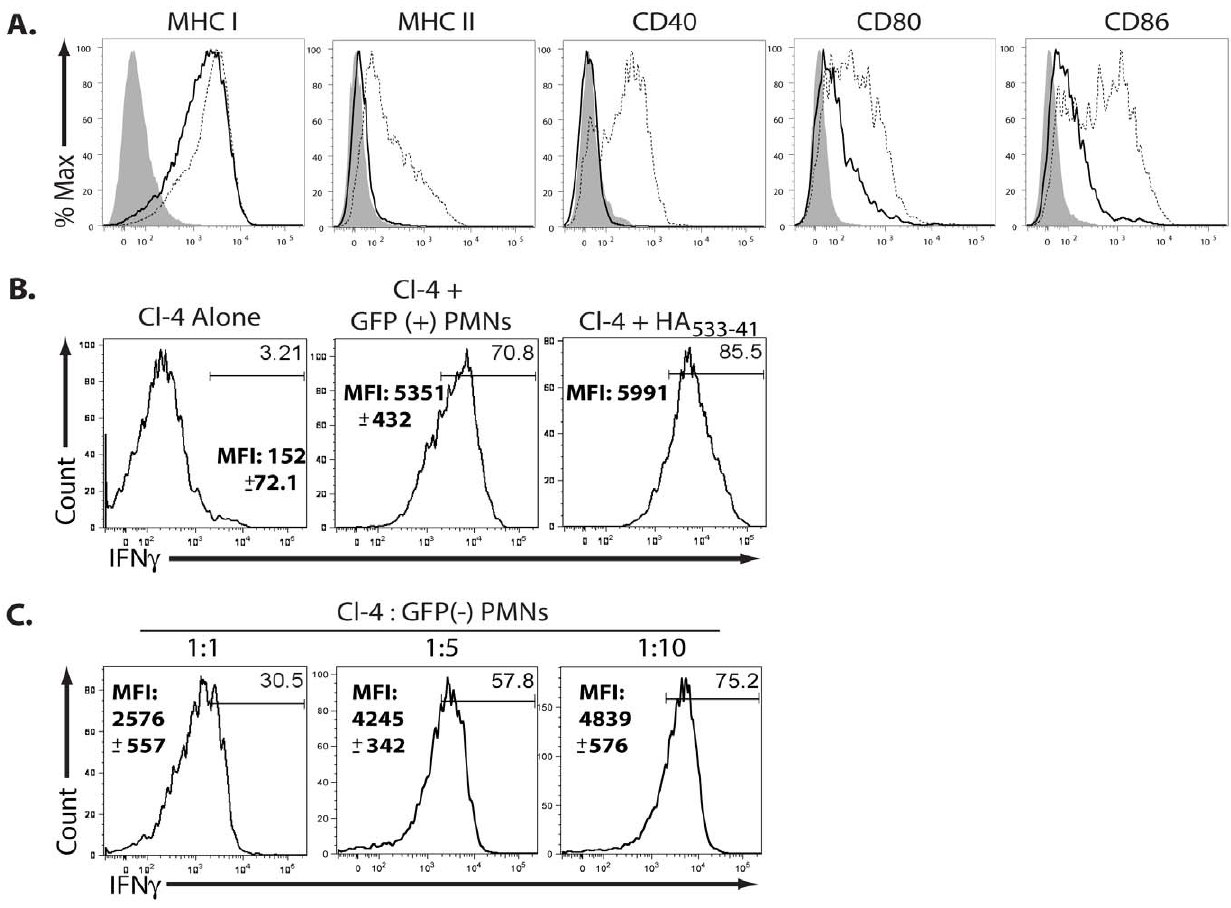
Figure 5. Neutrophils can stimulate CD8 + T cell pro-inflammatory cytokine production invitro . ( A ) BALB/c mice were infected with PR8 (0.1LD 50 ) and lungs were collected at 6 dpi. Inflammatory mononuclear cells (dashed lines) and neutrophil (solid line) MHC and co-stimulatory molecule expression is depicted. Isotype control is shaded area. Two independent experiments (n=2–4/expt). ( B–C ) BALB/c mice were infected with NS-GFP influenza virus. At 5 dpi, lung neutrophils (CD45 + , Thy 2 , Ly6G hi , Ly6C int , CD11b hi ) were sorted based on GFP expression. In parallel, 2 6 10 5 CL- 4 CD8 + Thy1.1 + were adoptively transferred into Thy1.2 + BALB/c mice and were infected with PR8 (0.1LD 50 ) the following day. At 8 dpi, lung CL-4 cells (CD45 + , Thy1.2 2 , Thy1.1 + CD4 2 ,CD8 + ) were sorted and cultured ( B ) in a 1:1 ratio with GFP + neutrophils or ( C ) in depicted effector:target ratios with GFP 2 neutrophils. ( B–C ) Cells were co-cultured for six hours in the presence of GolgiStop. Representative flow profiles depict CL-4 T cell (CD45 + CD8